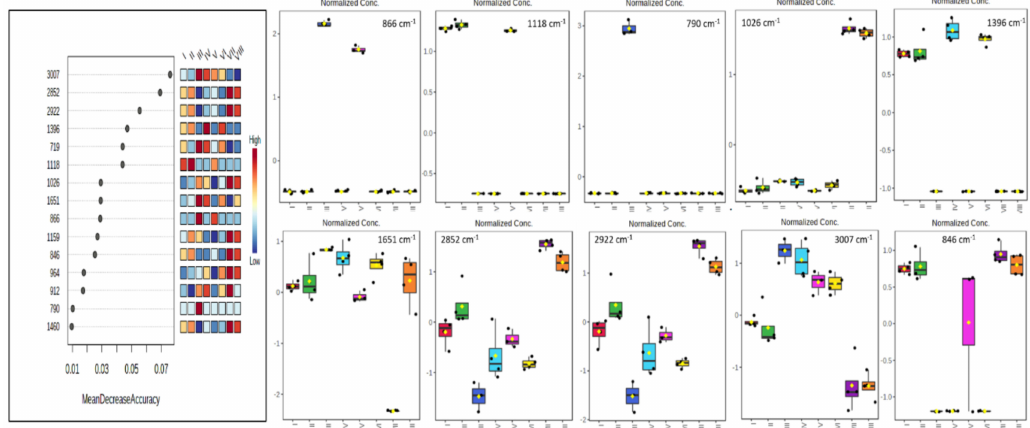
Figure 7. ANOVA Univariate analysis using Random forest algorithm and post-hoc analysis by Fischer’s least significant di ff erence (LSD) to predict the discrimination between the 8 groups based on specific FTIR-MIR wavenumbers and absorption